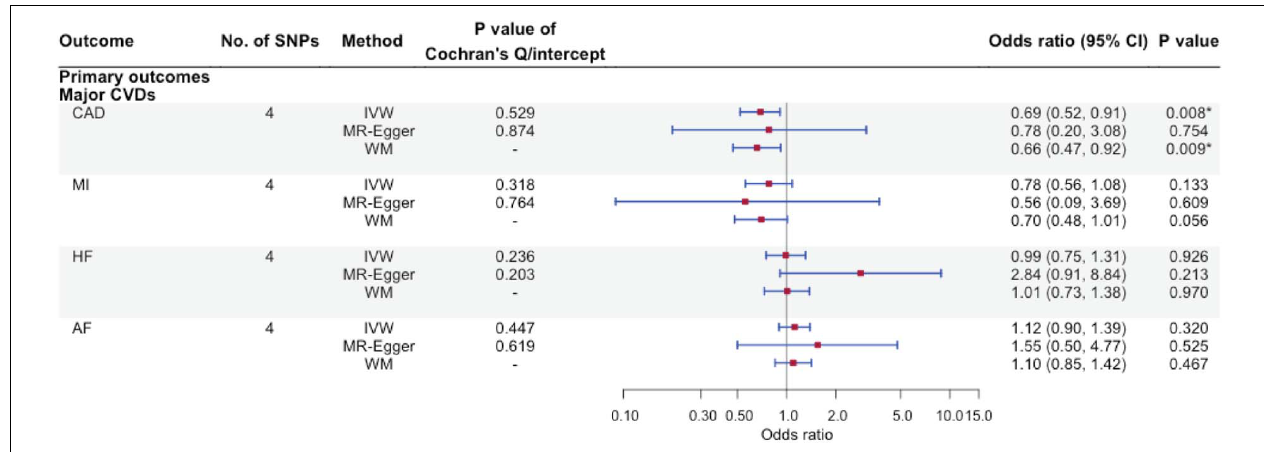
FIGURE 2 | The associations of genetically predicted FGF23 and major cardiovascular diseases using Mendelian randomization. No. of SNPs, number of single nucleotide polymorphisms; IVW, inverse-variance weighted; WM, weighted median; CVD, cardiovascular disease; CAD, coronary artery disease; MI, myocardial infarction; HF, heart failure; AF, atrial fibrillation. ∗ Bonferroni-corrected P -value <